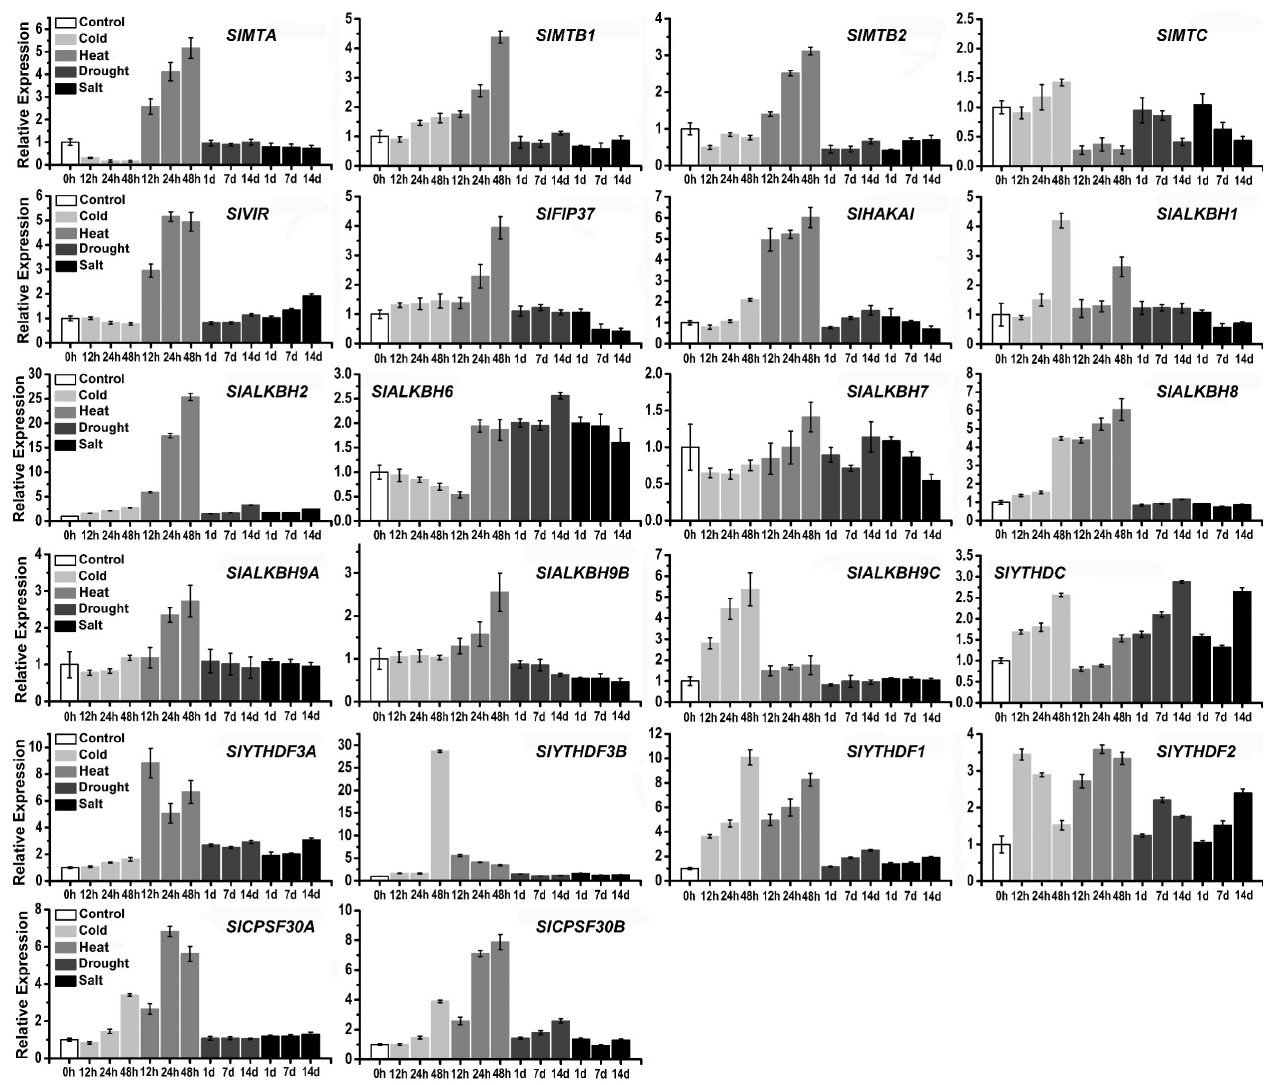
Figure 6. Expression profiles of tomato m 6 A genes in different abiotic stress by qPCR analysis. The 30-day-old tomato seedlings were treated under cold and heat conditions for 12, 24, and 48 h. Tomato seedlings were treated under drought and salt condition for 1, 7, and 14 d. Tomato seedlings without treatment was considered the control. Each value represents the mean ± SE of three